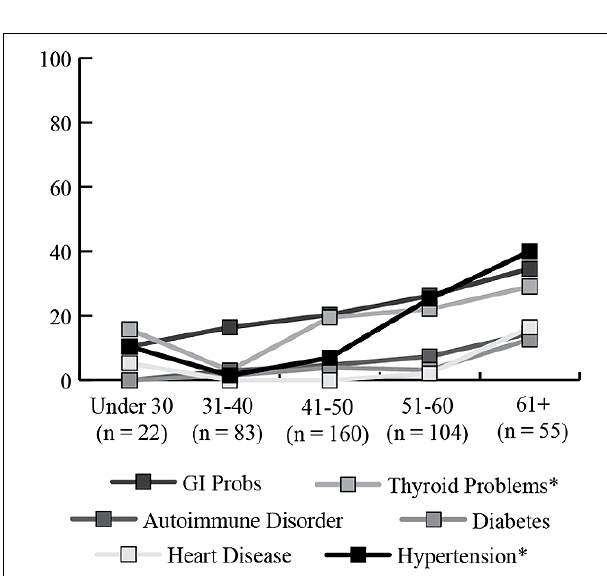
FIGURE 4 | Percentage of women endorsing co-occurring medical conditions, by age group. *Significant increases in older age groups.